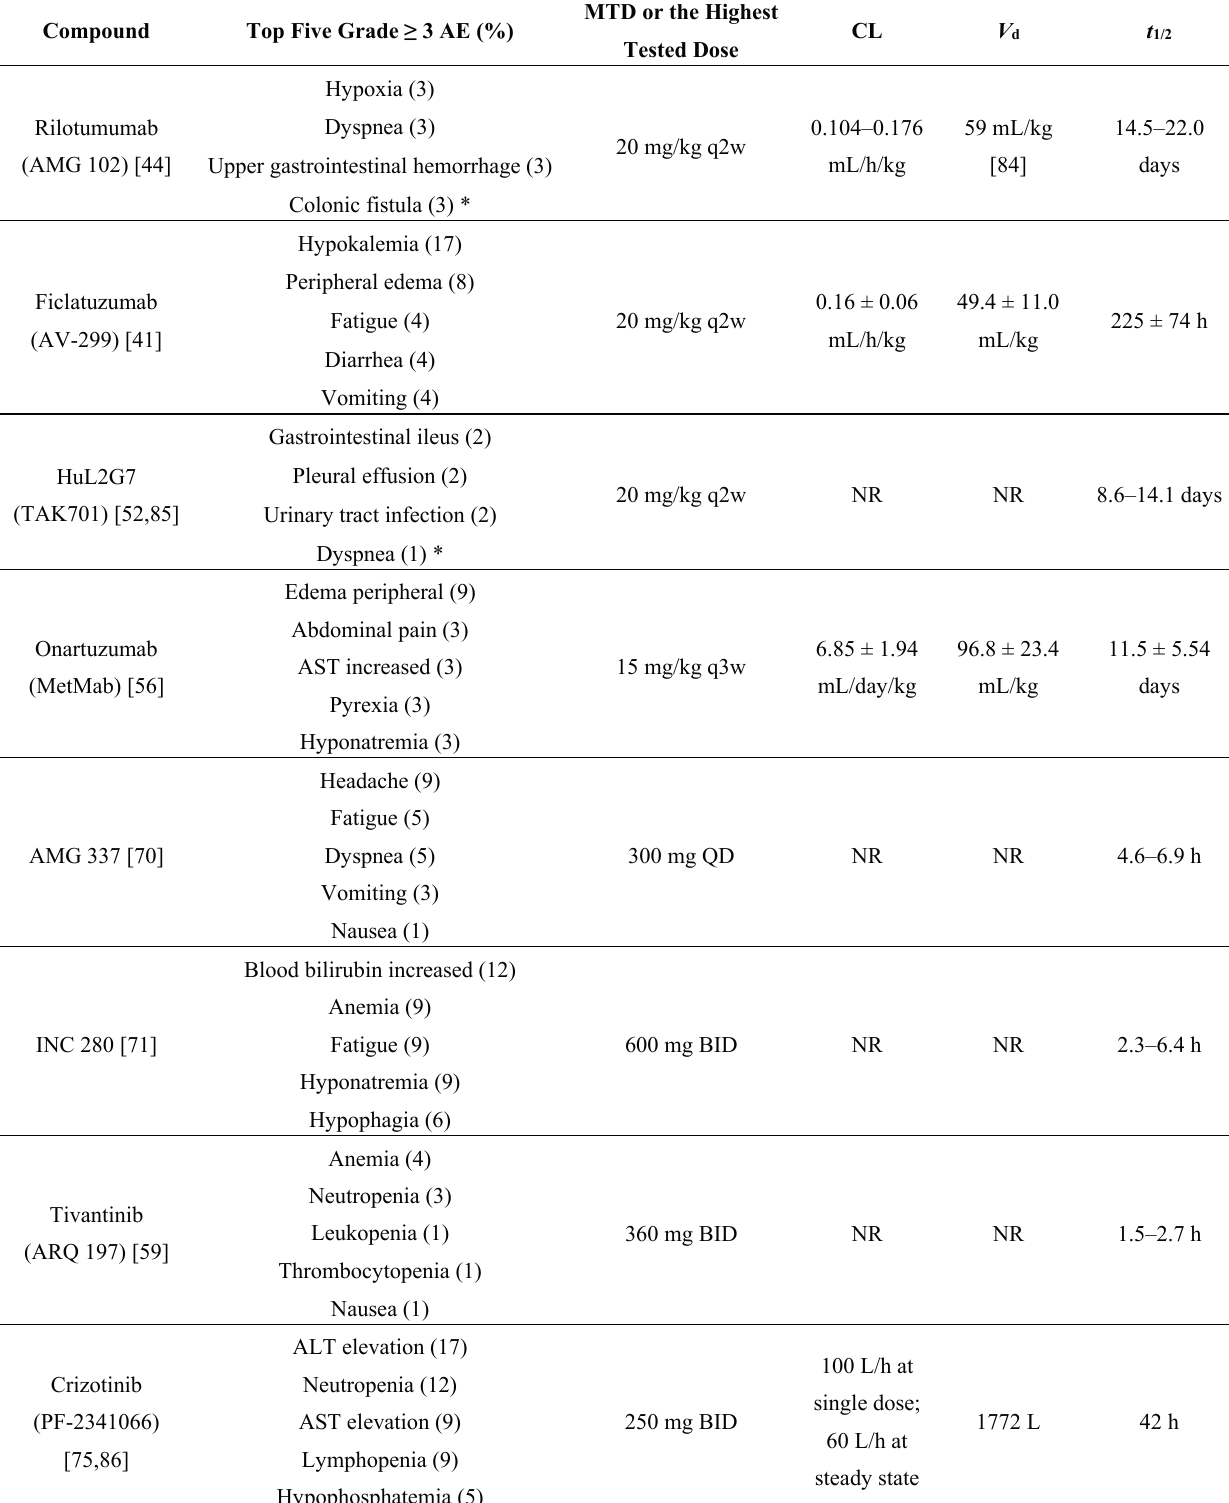
Table 2. Summary of pharmacokinetic parameters and top FIVE grade ≥ 3 adverse events (AEs) of selected HGF/MET inhibitors when administered as a single